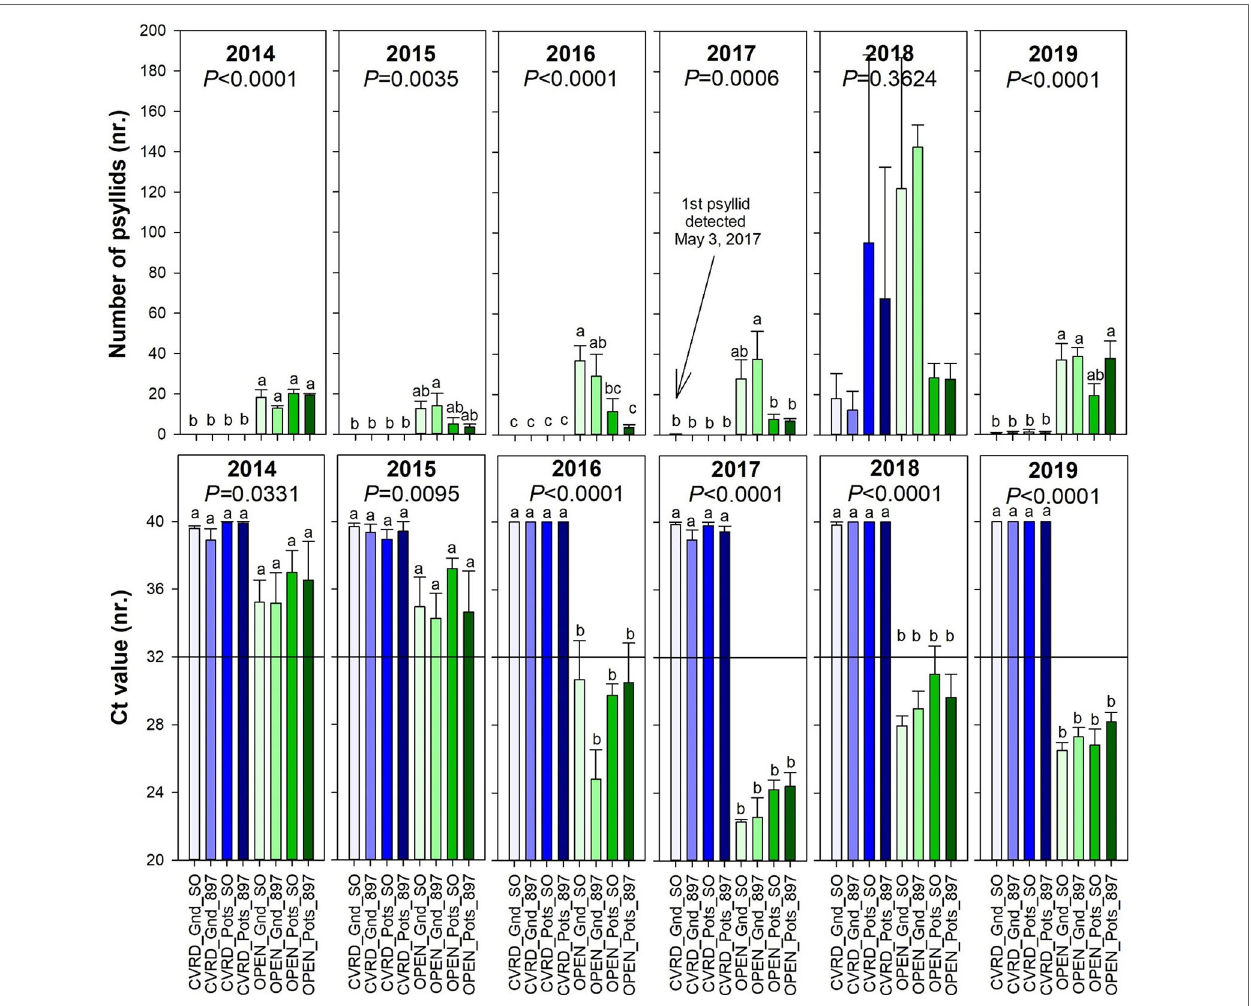
FIGURE 3 | Number of psyllids (top) and cycle threshold (Ct) value of Candidatus Liberibacter asiaticus ( C Las) deoxyribonucleic acid (DNA) (bottom) of “ Ray Ruby ” grapefruit trees cultivated under two production systems (screenhouse, CVRD and open-air, OPEN), two planting systems (in-ground, GND and potted, POTS), and two rootstocks ( “ Sour Orange, ” SO, and “ US-897 ” ), with four replications arranged in a split-split-plot experimental design. Mean ± standard error of four replications. Means with the same letter are not signi fi cantly different from each other at 5% probability ( P ≤ 0.05) using Tukey mean comparison test. Reference line on bottom graph indicate the threshold to consider trees infected by C Las : < 32 negative and ≥ 32